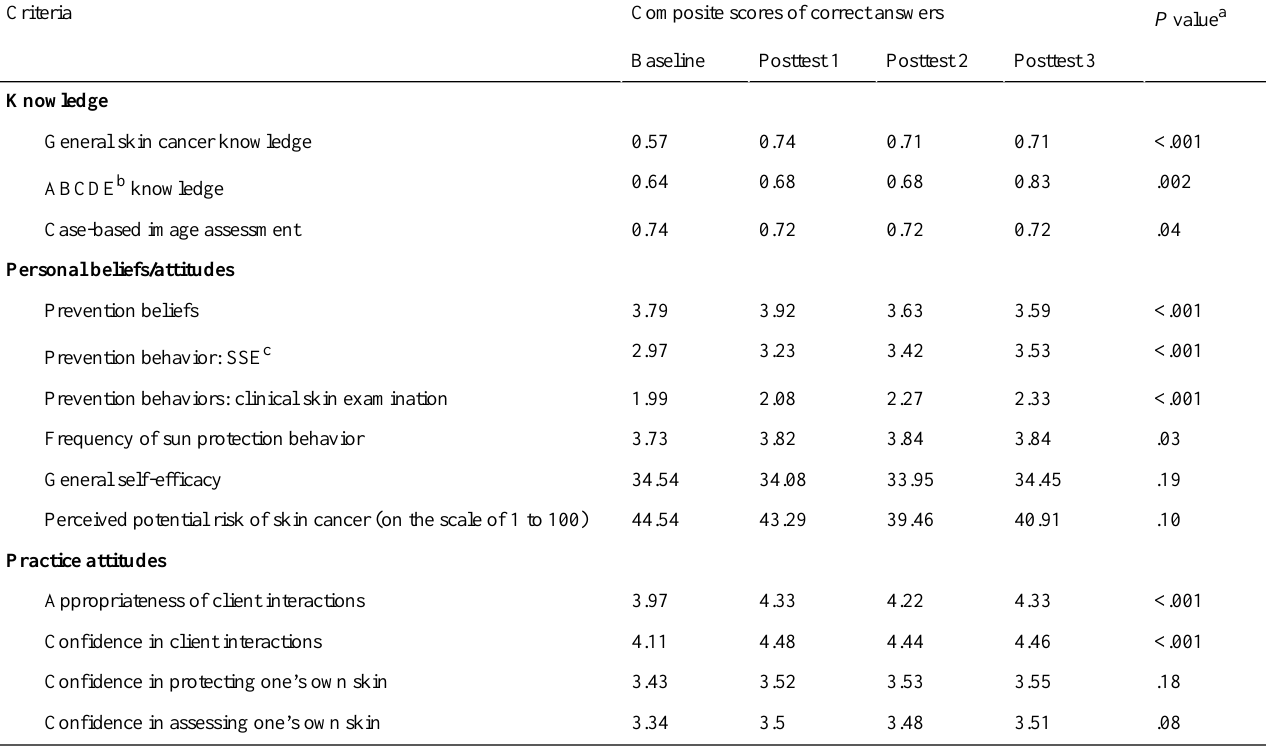
Table 3. Knowledge, personal beliefs/attitudes, and practice attitudes.